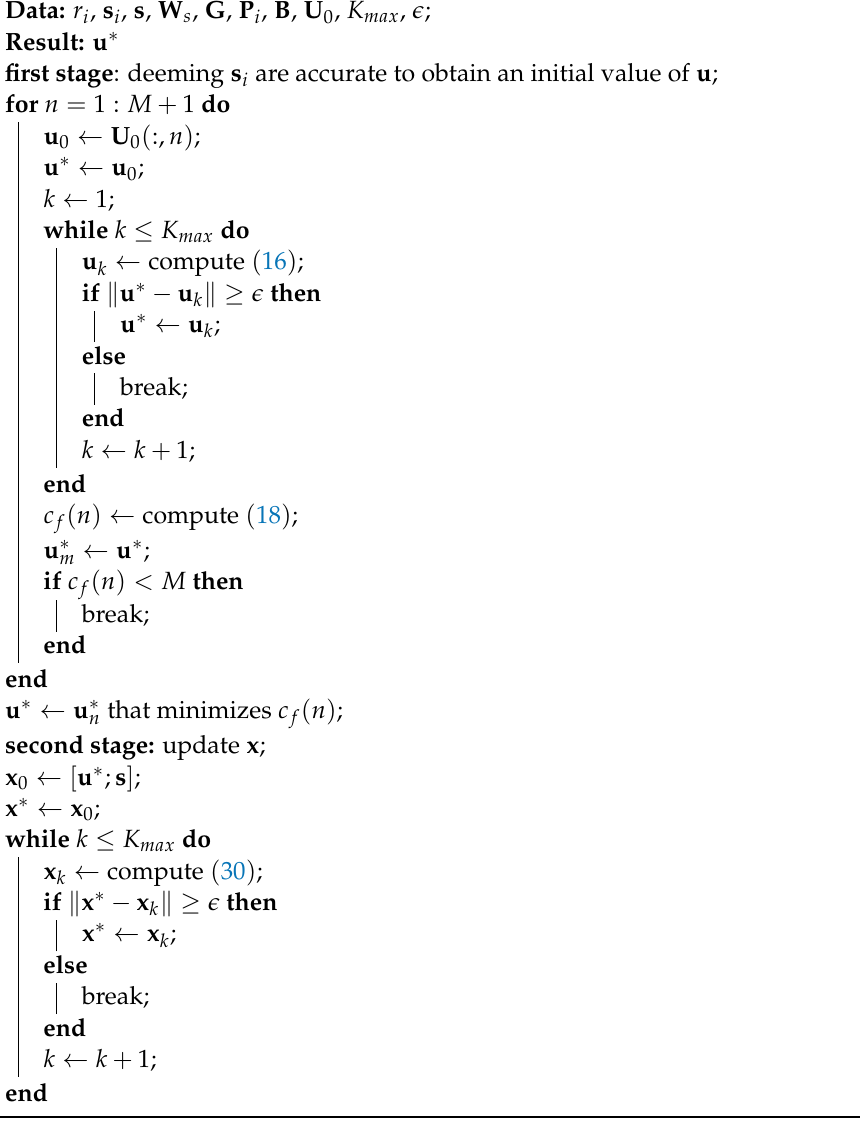
Algorithm 2: Localization with scenario 2: non-accurate sensor